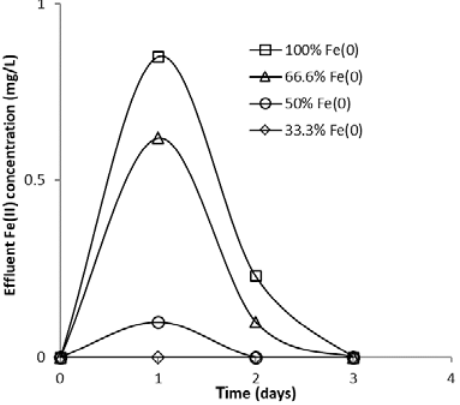
Figure 18. Fe II concentration in column effluent vs. time for columns having fixed Fe 0 volume and variable total reactive zone volume V 2 at initial pH 6.5 .